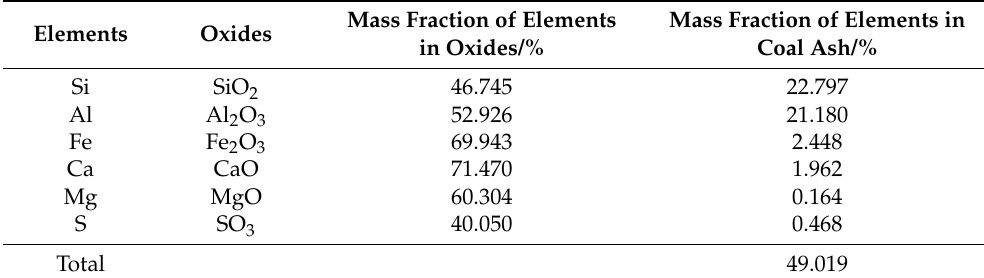
Table 1. Mass fraction of high-Z elements in medium-clean coal ash from the Linhuan plant.